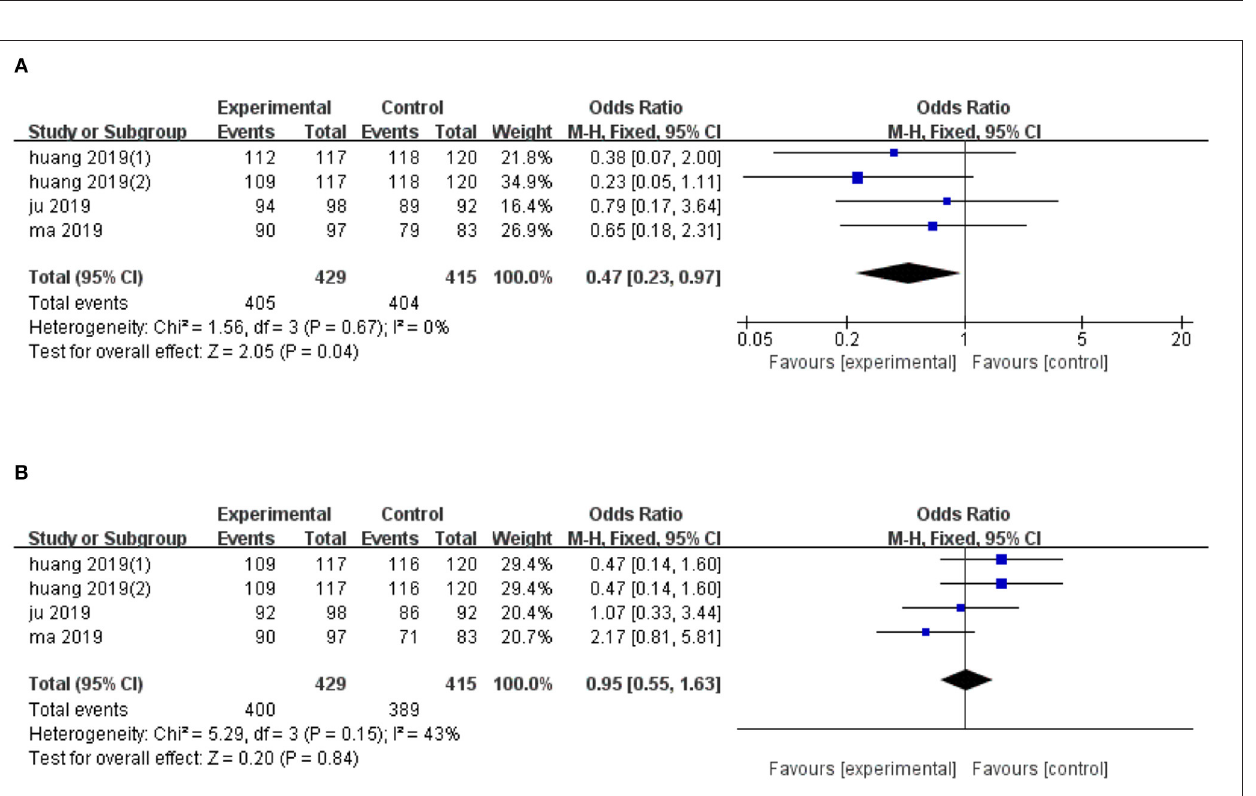
FIGURE 4 | Forest plot of the effects of ultrasonic image fusion on complications.